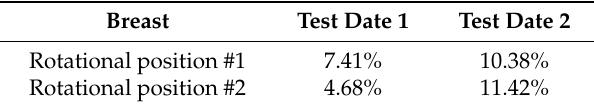
Table 4. QA Metric 4, Evaluated for the Four Analyzed Test Datasets.